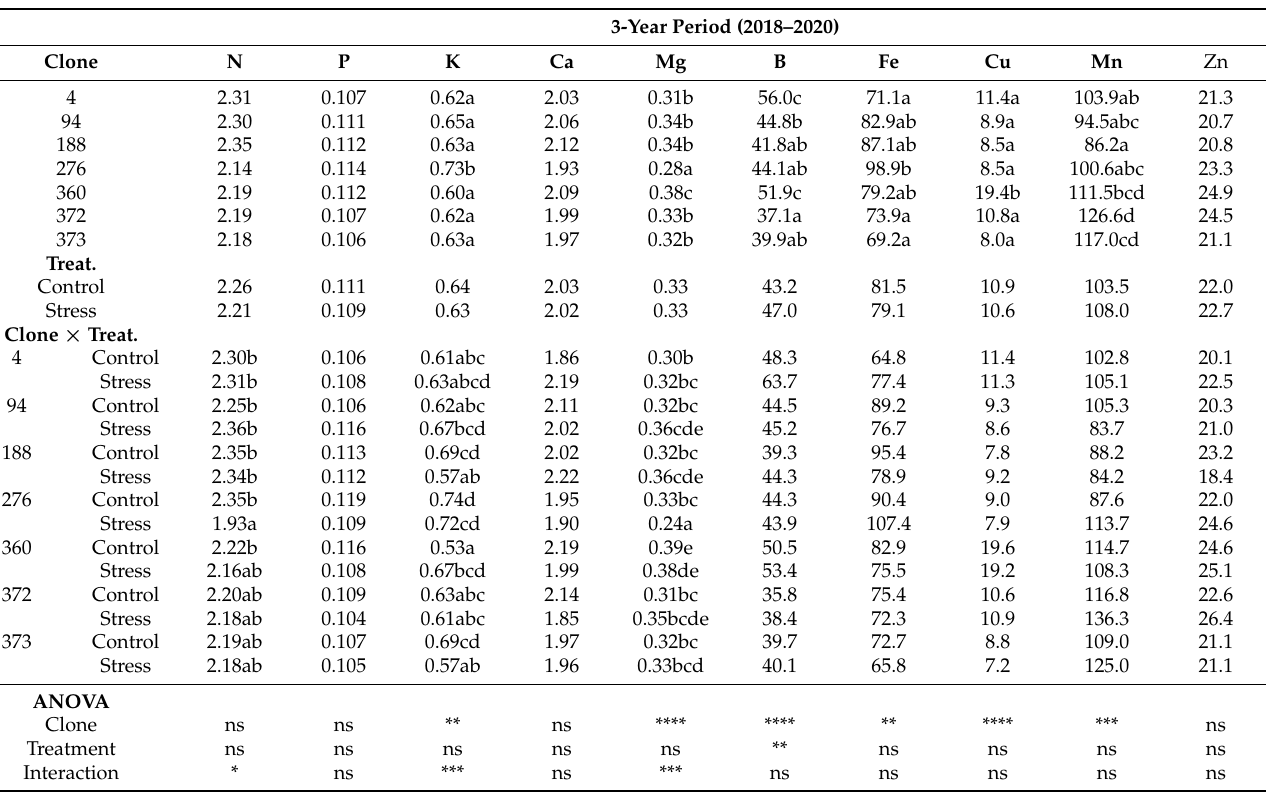
Table 4. Leaf nutrient concentrations of Monastrell grapevines at veraison for each clone, irrigation treatment, and the interaction (clones × irrigation treatment) during the 3-year period 2018–2020. N, P, K, Ca, and Mg are expressed as % in DW, and Fe, Cu, Mn, Zn, and B as